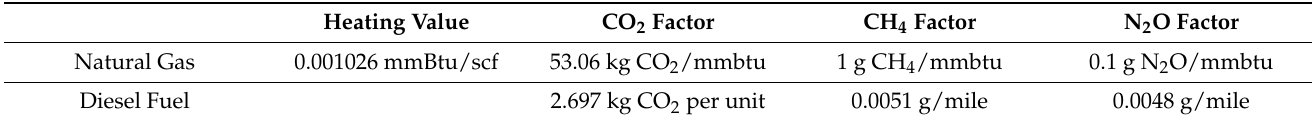
Table 5. Stationary combustion emission factors for natural gas.